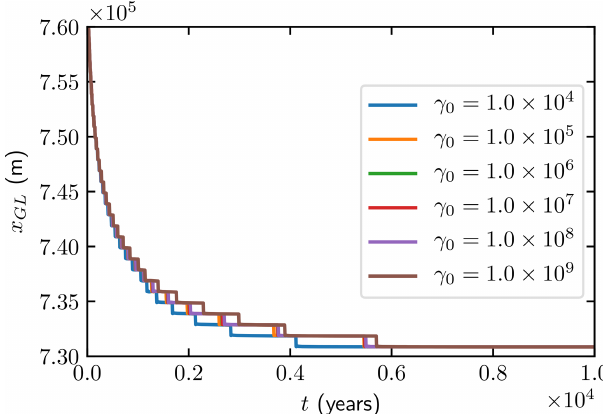
Figure 4. The MISMIP 3a retreat experiment with (cid:49)x = 1km for different choices of γ 0 in the time interval [ 0 , 10000 ] years.